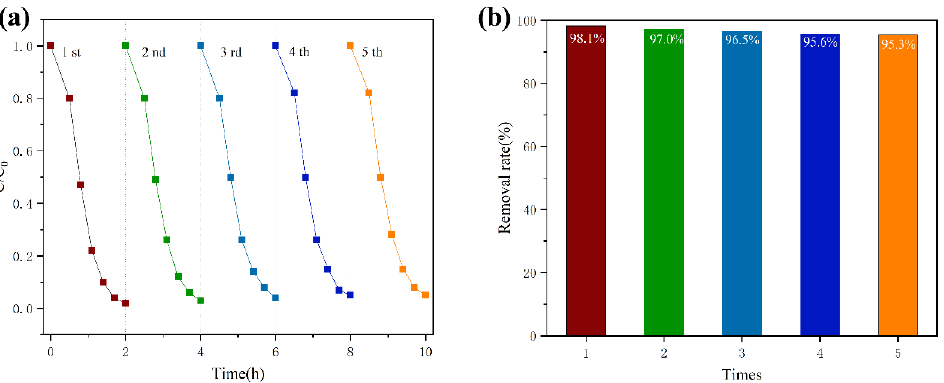
Figure 10. ( a ) Photocatalytic activity and ( b ) cycling test and reusability of g-C 3 N 4 /Ag 3 PO 4 / TiO 2 /PVDF membranes under visible light irradiation for five cycles (initial RhB concentration of 10 mg/L, pH =